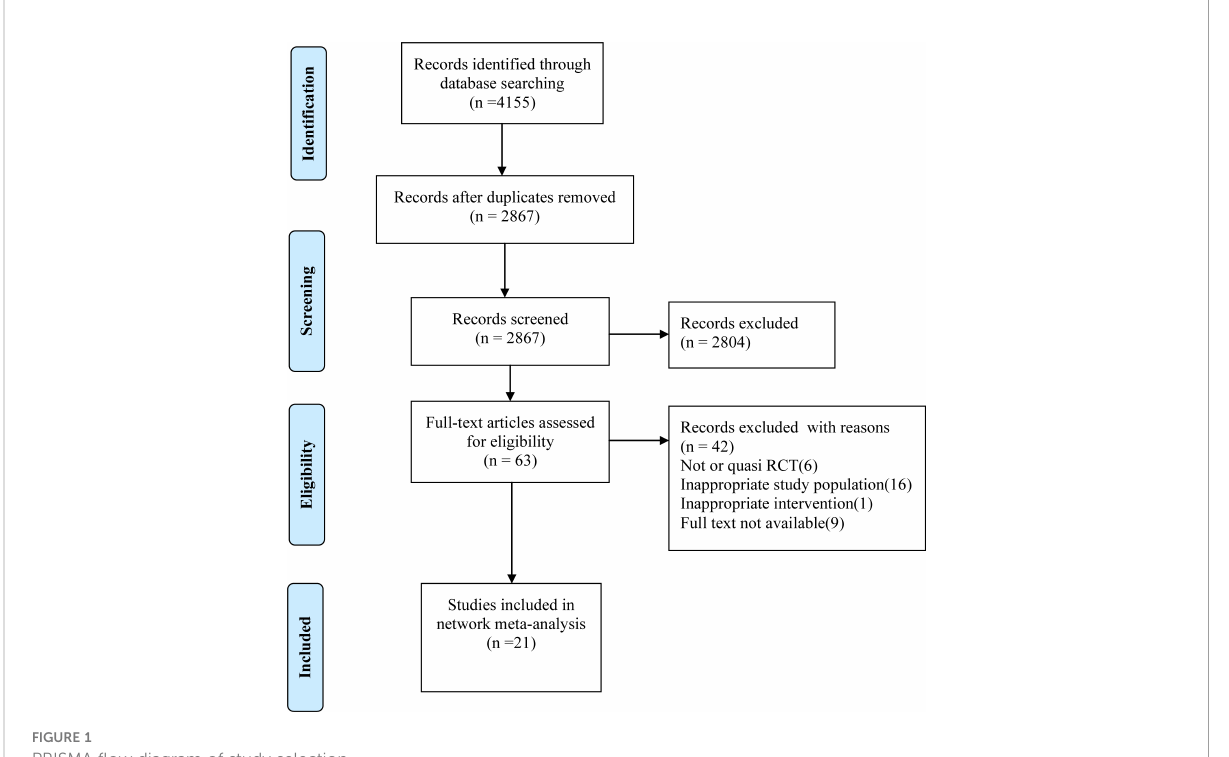
FIGURE 1 PRISMA fl ow diagram of study